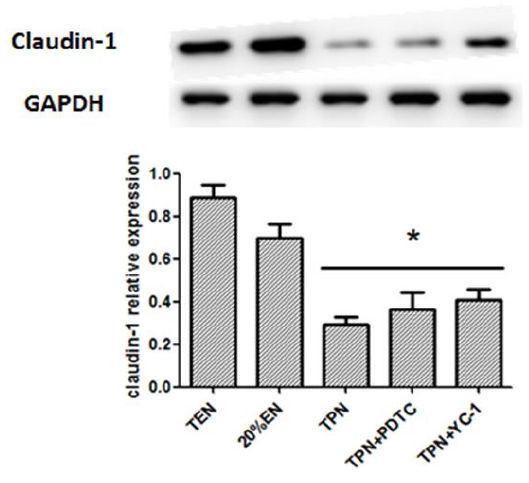
Figure 8. Western blotting analysis of claudin-1 in the intestine mucosa of all groups. It demonstrated obviously decreased claudin-1 in TPN, TPN+PDTC and TPN+YC-1 compared with TEN group ( p = 0.022, 0.035 and 0.041, respectively). No statistical difference was found between the TEN and 20%EN groups. * p < 0.05, compared with TEN group.